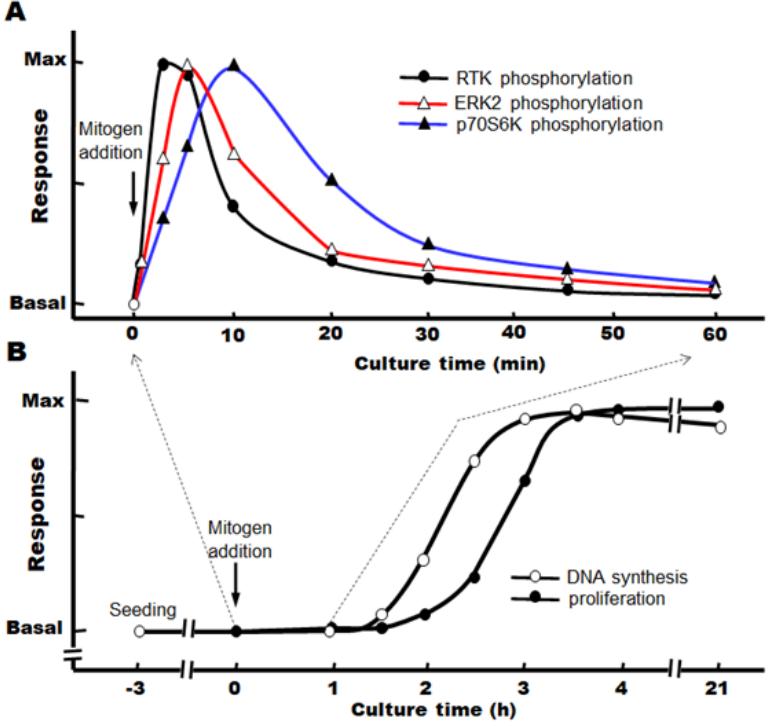
Figure 3. Time course of hepatocyte proliferation stimulated by mitogens in primary cultures. ( A ): Phosphorylation of signaling factors by mitogens, ( B ): DNA synthesis and hepatocyte proliferation induced by mitogens.